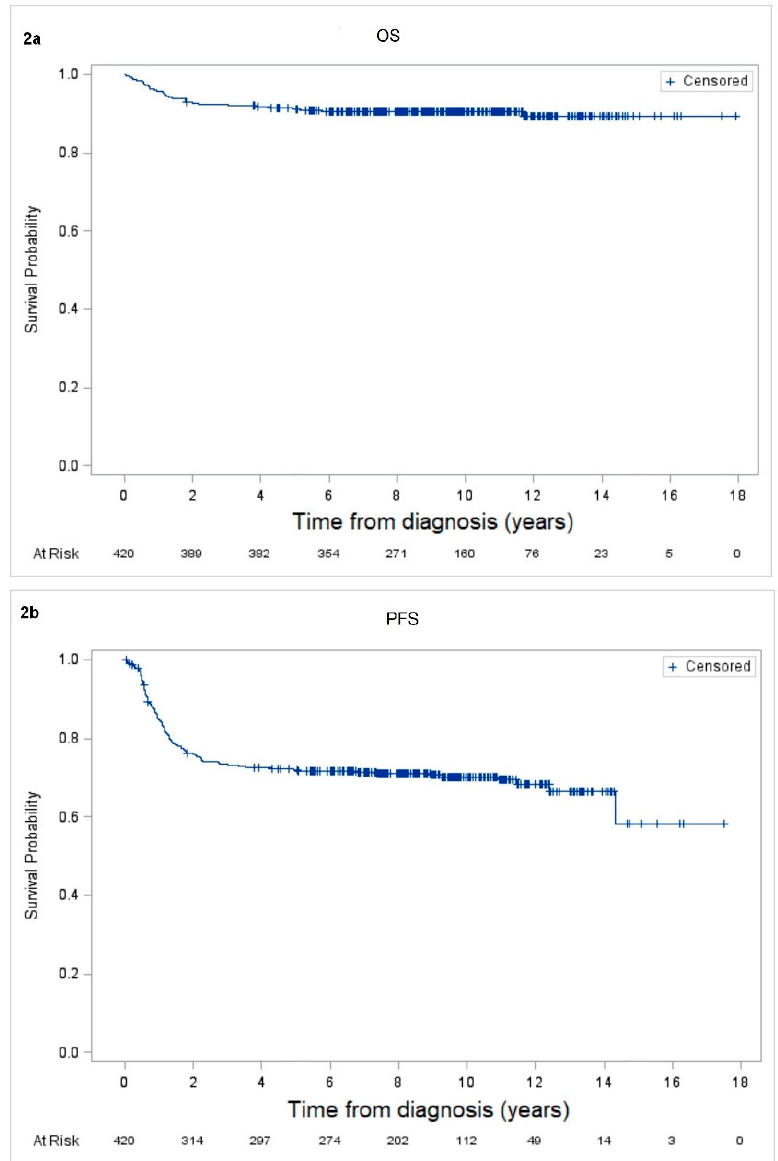
Figure 2. The 10-year overall survival (OS) and progression free survival (PFS) were 90% (SE ± 1%) ( a ) and 70% (SE ± 2%) ( b ), respectively, for the full cohort of 420